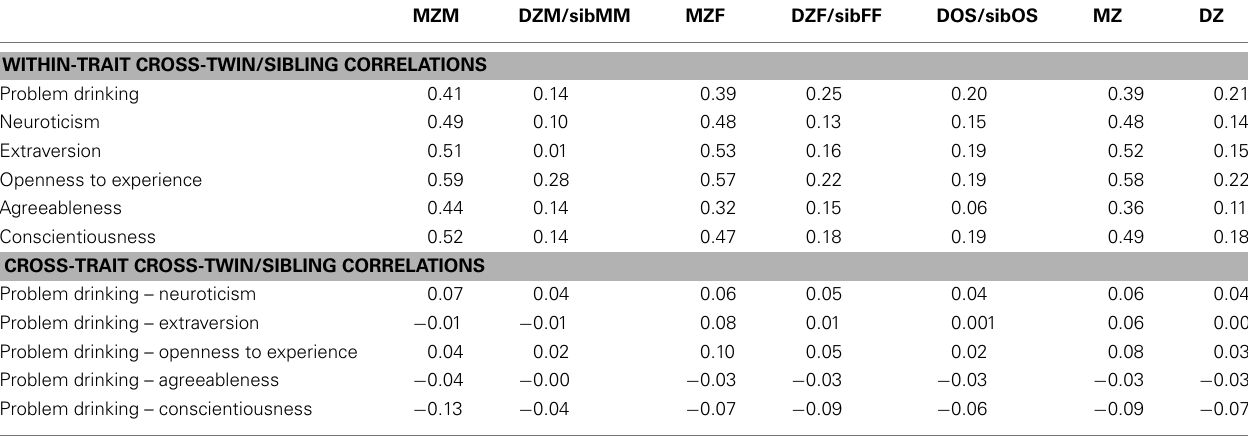
Table 3 |Twin/sibling correlations for problem drinking and the FFM personality scales as obtained from the saturated models.